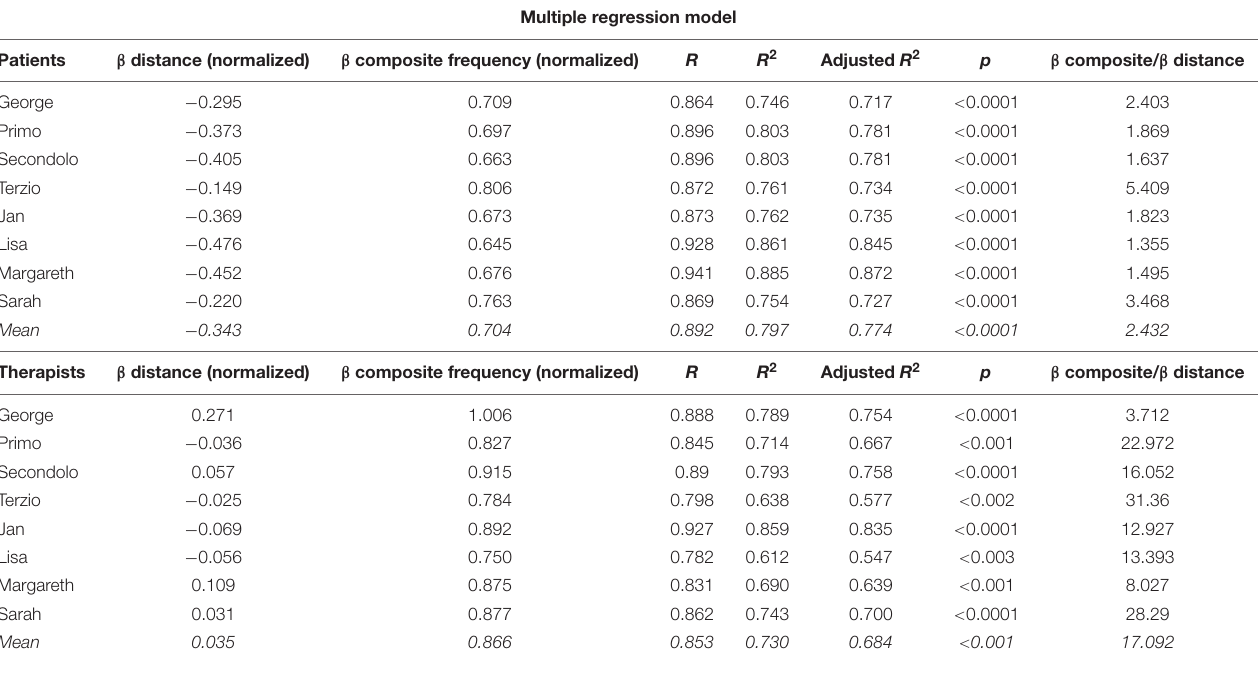
TABLE 5 | Results of the multiple regression model applied to each